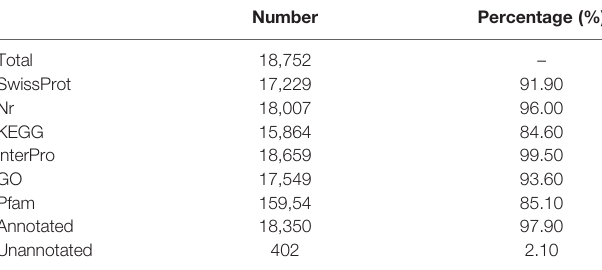
TABLE 4 | Summary of functional annotations for predicted genes.